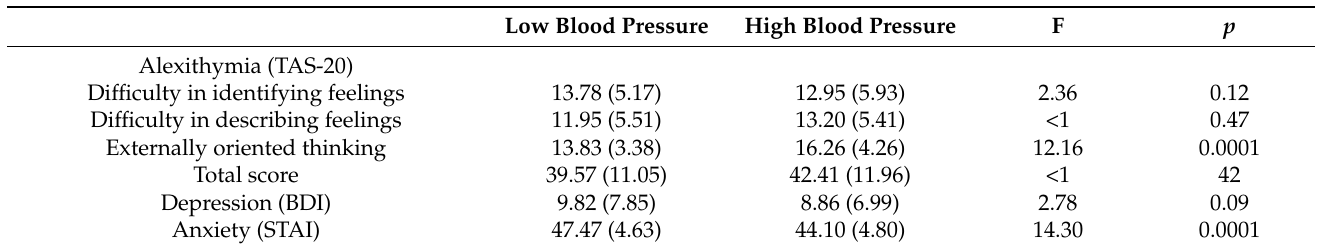
Table 4. Mean and standard deviation of the psychological dimensions in low blood pressure and high blood pressure groups.